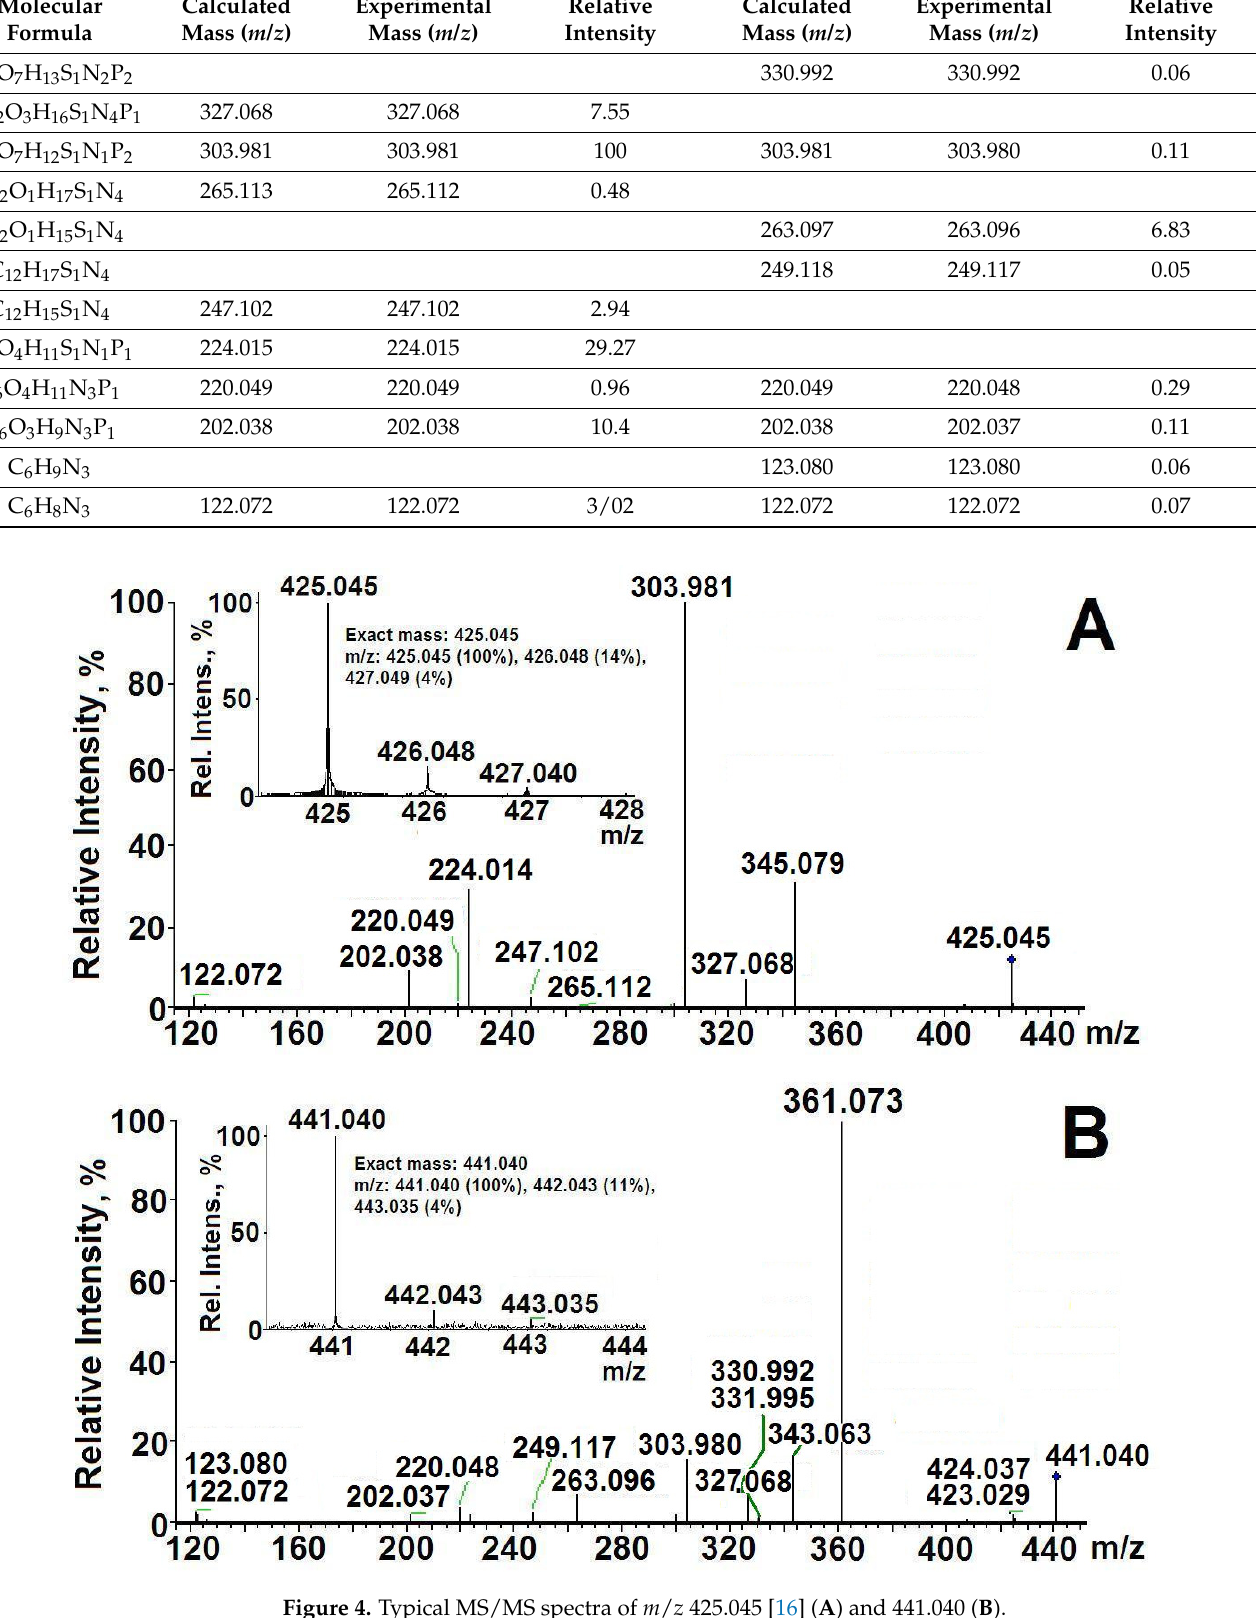
Figure 4. Typical MS/MS spectra of m / z 425.045 [16] ( A ) and 441.040 ( B ).